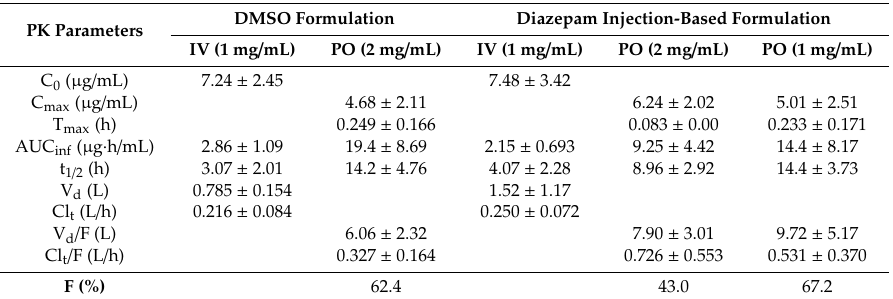
Table 1. Mean pharmacokinetics (PK) parameters of Ewha-18278 following IV (2 mg / kg) and oral (20 mg / kg) administrations to